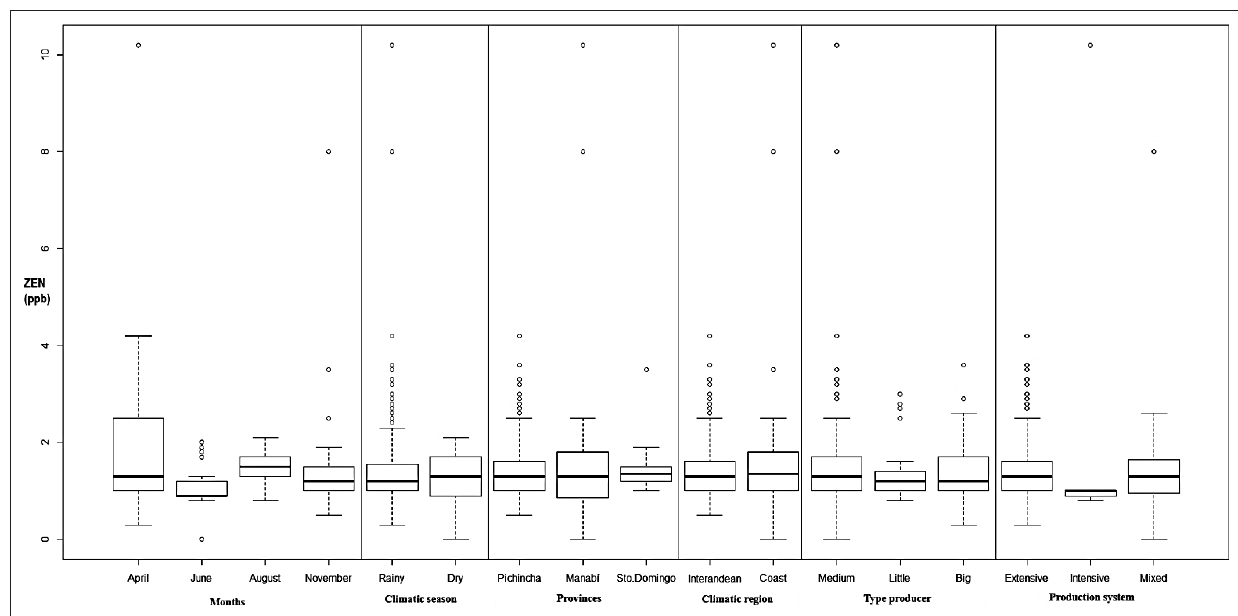
Figure-1: Boxplot with values according to months, climatic seasons, provinces, climatic regions, types of producer, and production systems. Table-2: Minimum, mean, and maximum values of ZEA obtained by months, climatic seasons, types of producer, and production systems